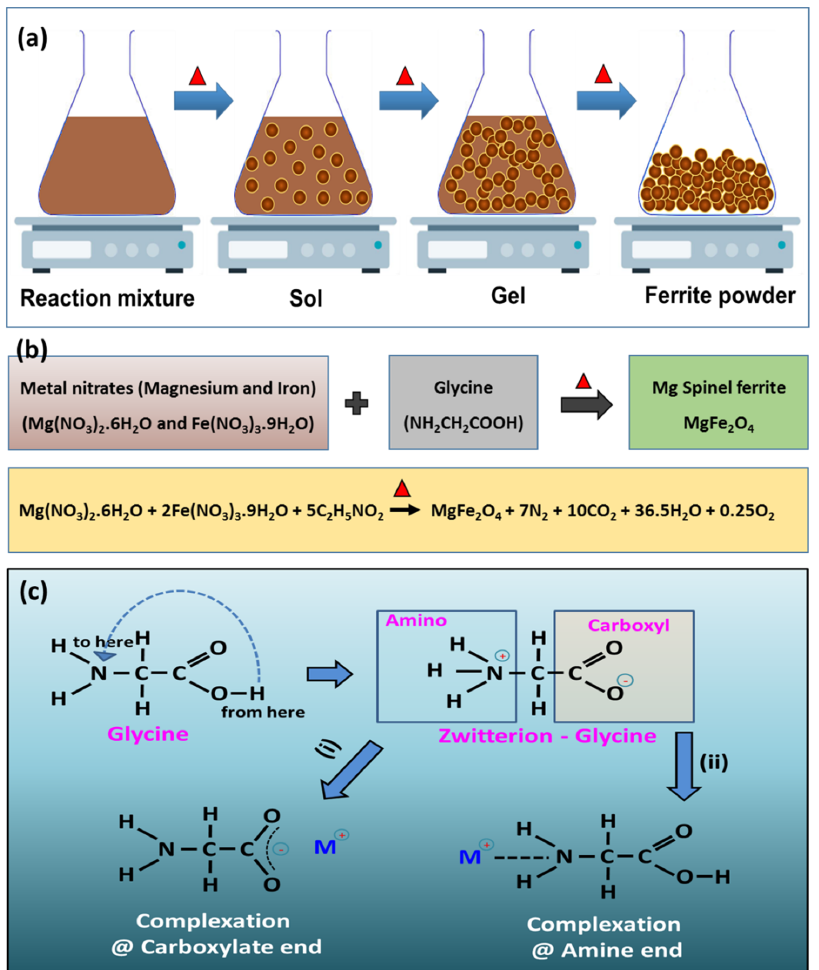
Figure 1. Schematic illustration of ( a ) preparation of ferrite powder, ( b ) reaction mechanism of MgFe 2 O 4 , and ( c ) zwitterion characteristics of glycine, respectively.